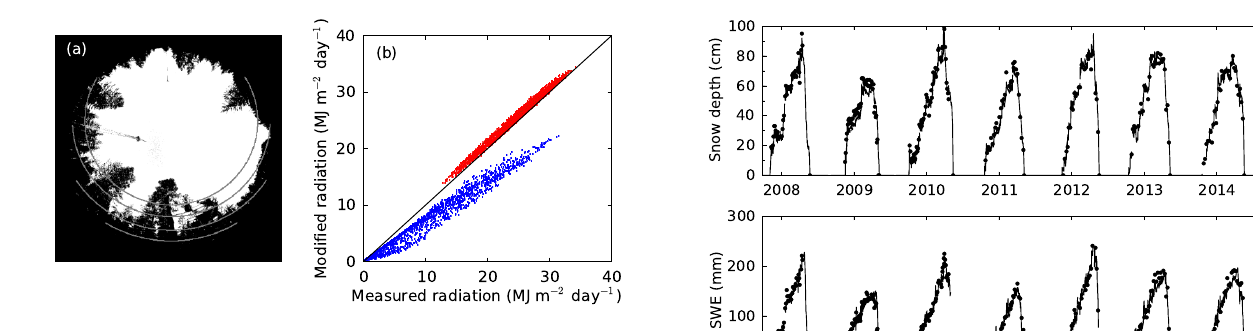
Figure 4. (a) A hemispherical photograph taken close to the IOA snow depth sensor in August 2011, showing the track of the sun (grey lines) on the first days of February, March, April and May. (b) Measured above-canopy and modified below-canopy daily solar (blue points) and longwave (red points) radiation.